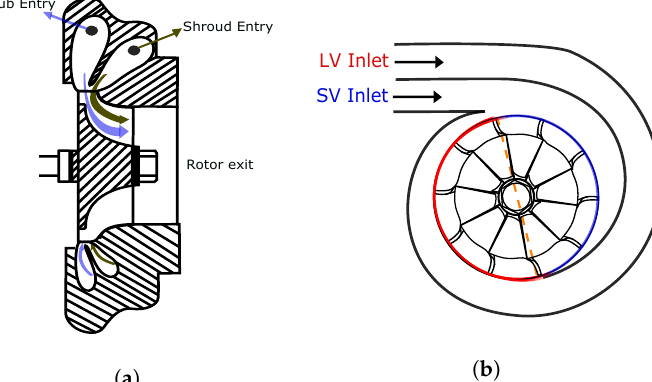
Figure 1. Difference in double entry radial turbine geometries due to their designs. ( a ) Twin-entry turbine (T#1TE) [12], ( b ) Dual-volute turbine